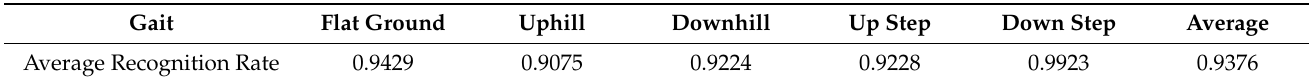
Table 6. Average recognition rate in 5 gaits of the BP neural